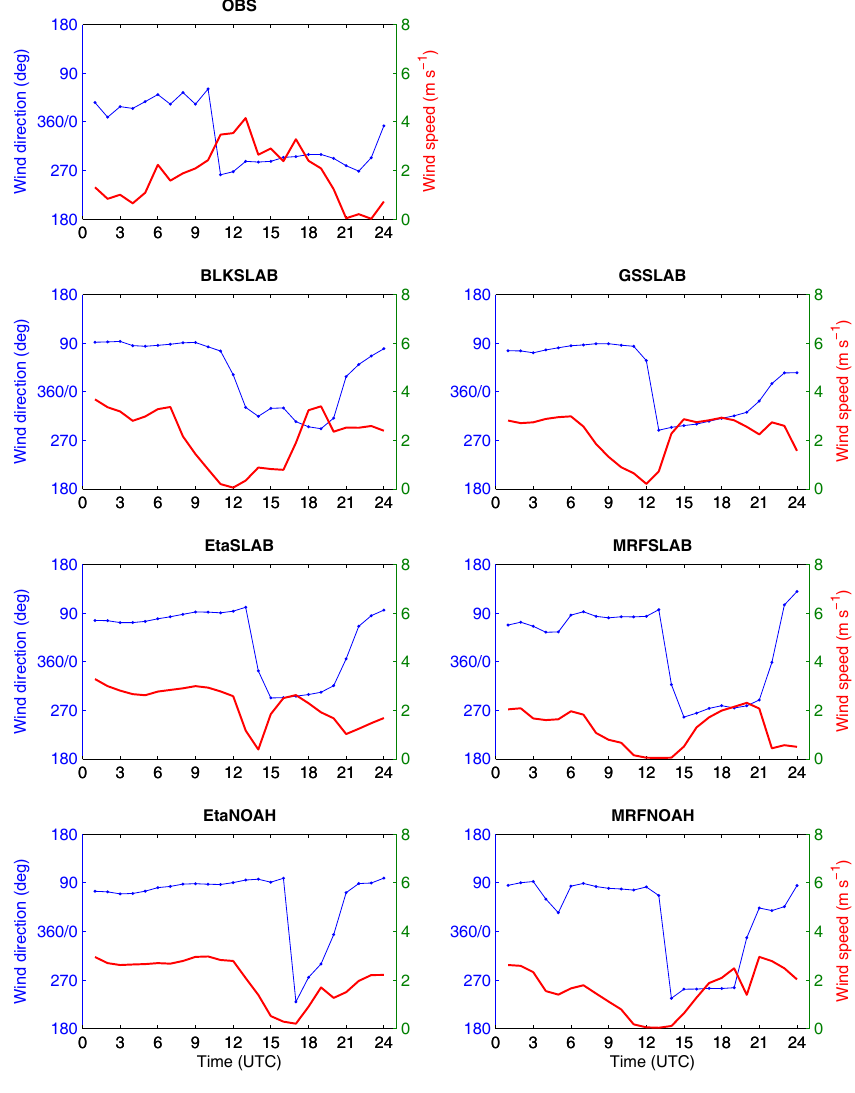
Fig. 4. Same as Fig. 2 but at J¨arnbrott